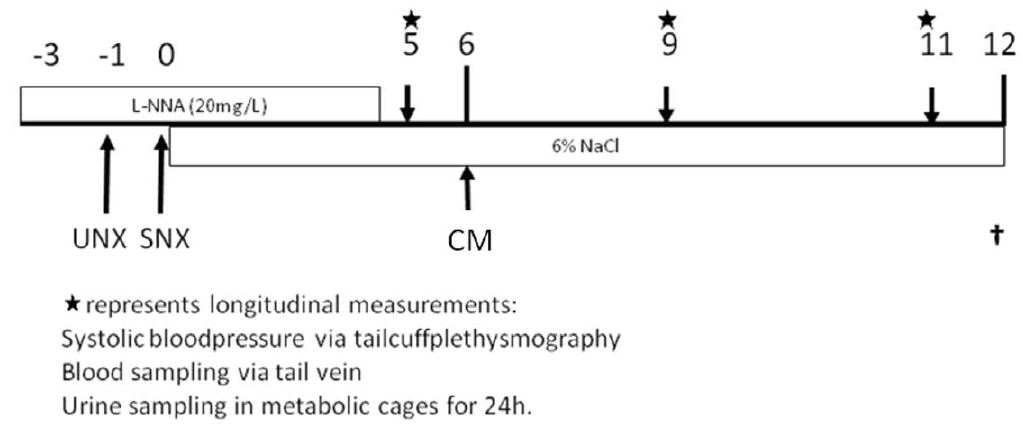
Figure 10. Representation of experimental set up. UNX=uninephrectomy; SNX=subtotal nephrectomy; CM=conditioned medium administration. Stars indicate longitudinal